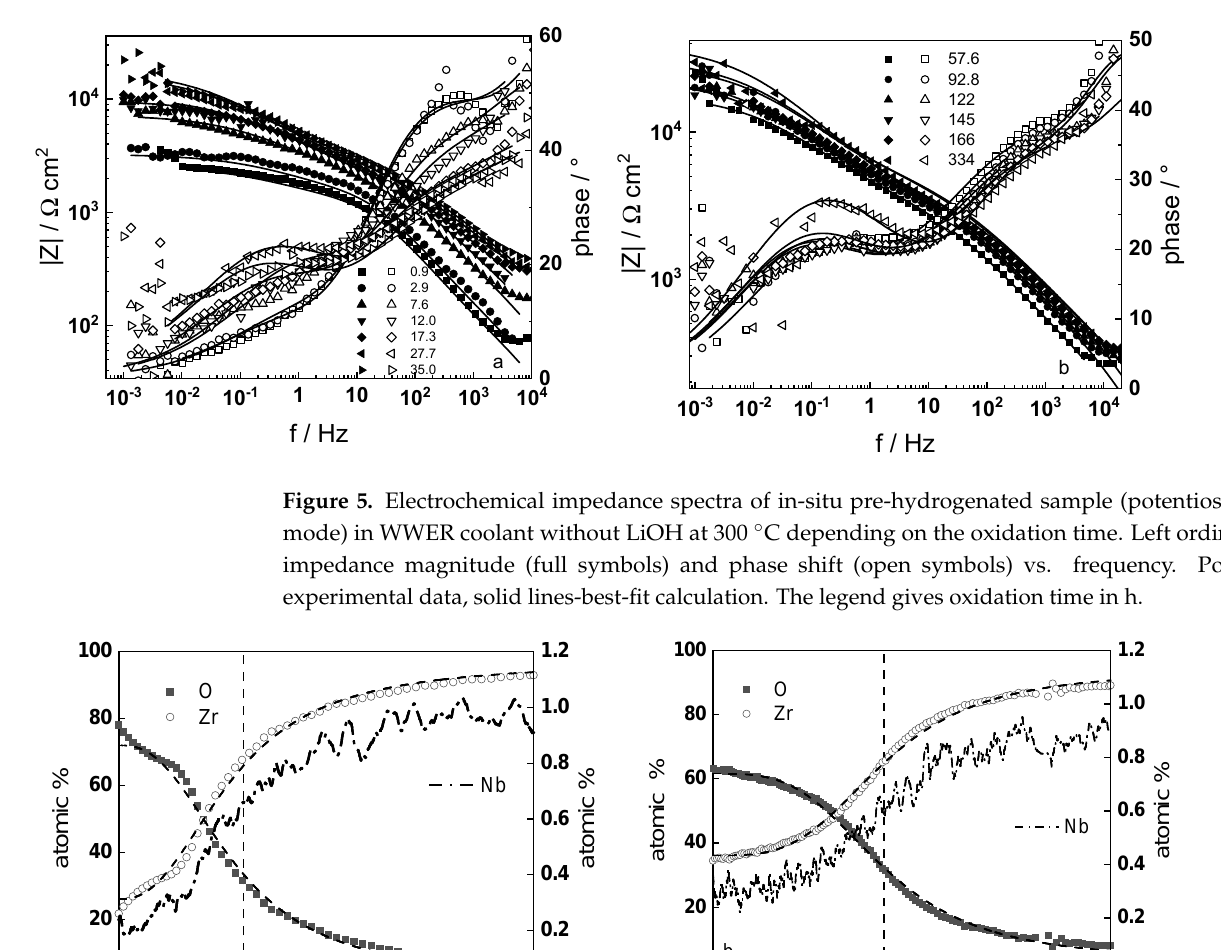
impedance magnitude (full symbols) and phase shift (open symbols) vs. frequency. Points-experi-